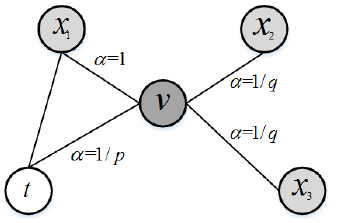
Figure 4. Setting of deviation coefficient in random